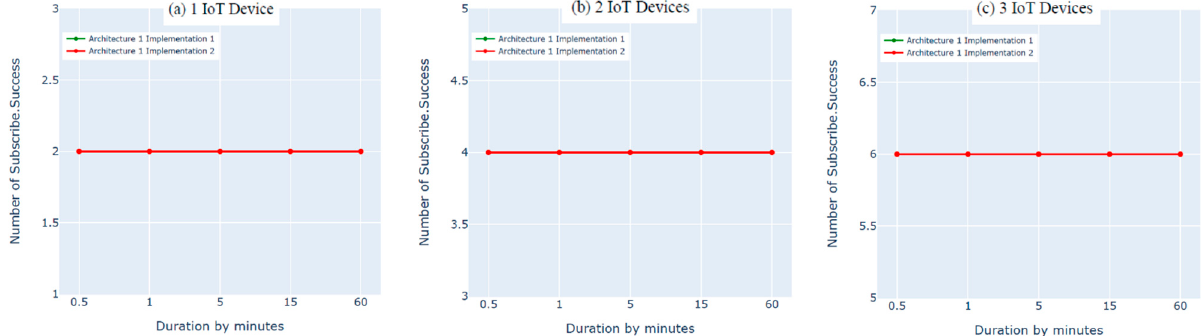
Figure 13. AWS IoT message broker Subscribe.Success metric with 1, 2, and 3 IoT devices on North Virginia datacenter (cloud layer).